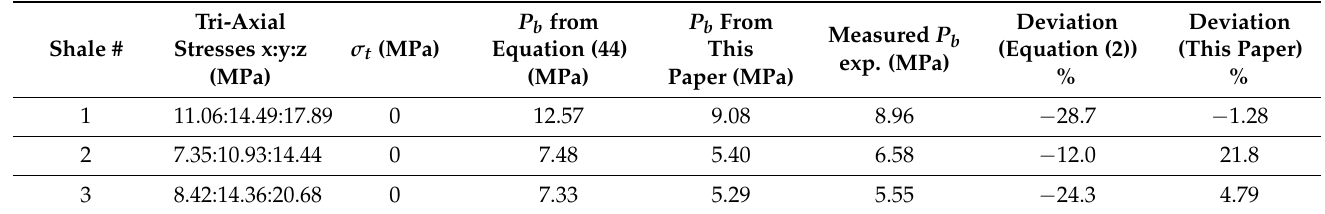
Table 5. Comparison between experimental (Wang et al., 2017) [46] and predicted